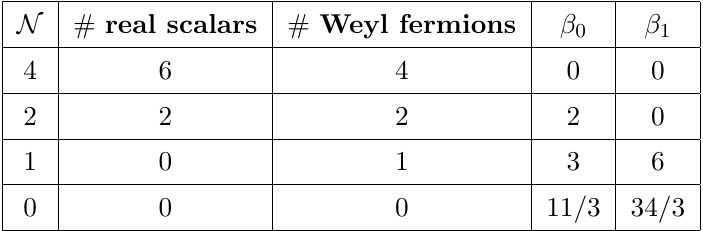
Table 2 . Field content and values for (cid:12) 0 and (cid:12) 1 for Yang-Mills theories with N = 0 ; 1 ; 2 ; 4